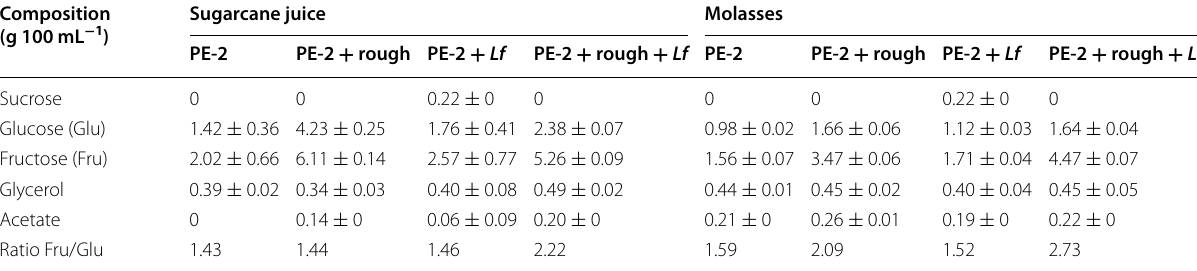
The analysis was carried out by HPLC Initial total reducing sugar concentration (in g 100 mL − 1 ); 17 (sugarcane juice) and 14 (molasses) Results are the mean standard deviation of two replicates ± Table 3 Kinetic constants for glucose and fructose con- sumption (k, in h − 1 ) and time to consume half (t , in h) 50 of the initial concentration of glucose and fructose cal- culated for the S. cerevisiae yeasts PE-2 (starter yeast) and the rough strain in semi-synthetic medium contain- ing both glucose and fructose as carbon sources, at 30 °C, without agitation Culture Glucose